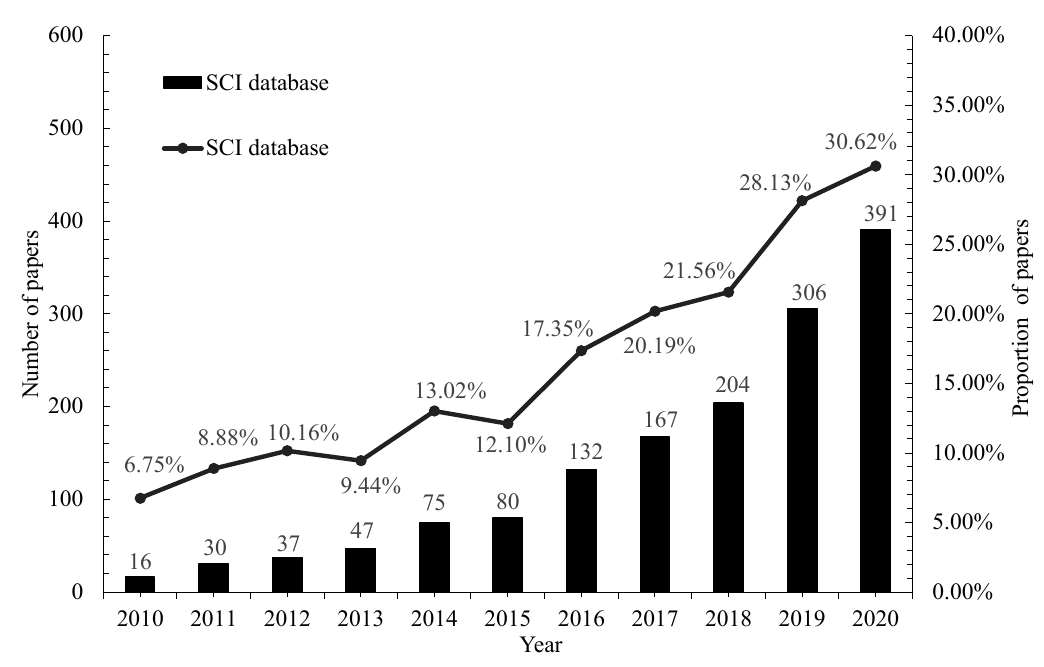
Figure 9. Chinese scholar articles collected in the SCI database. Table 2. Key technologies for wind power developed in China from 2010 to 2020. Technology Technical Points